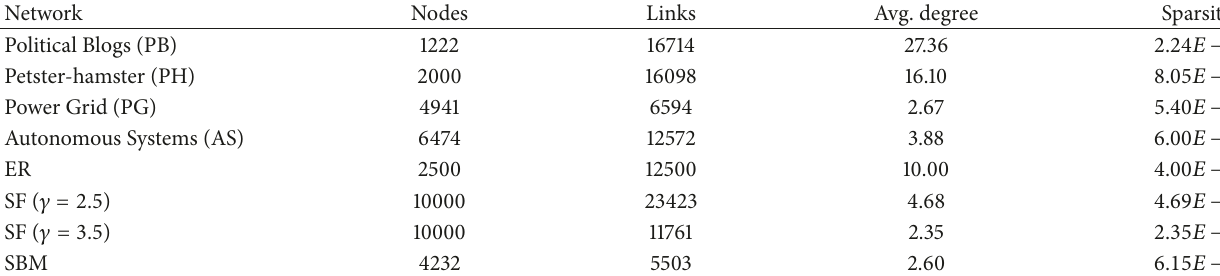
Table 1: Basic statistical features of the GCCs of the eight real and synthetic